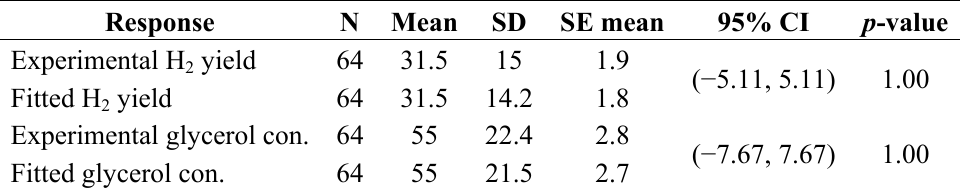
Table 5. Two-sample t -test for both